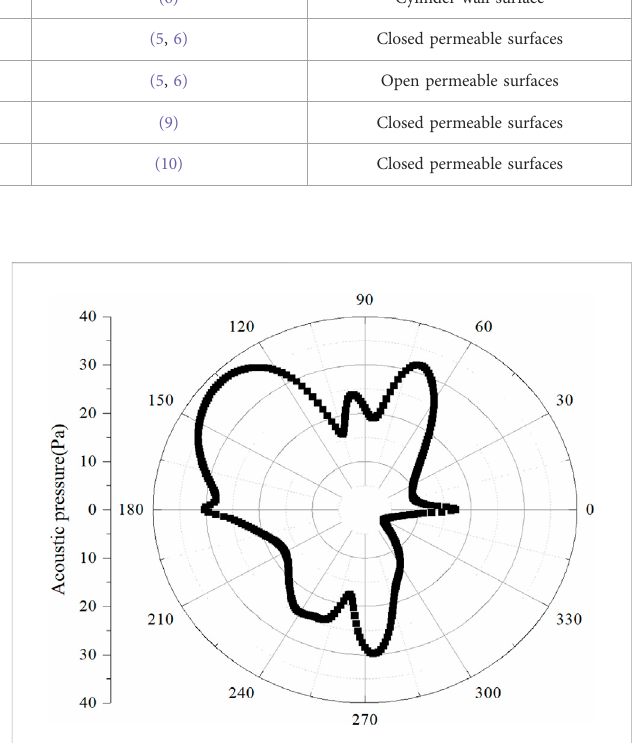
FIGURE 7 Acoustic results for the FW-H equation with impermeable wall surface.